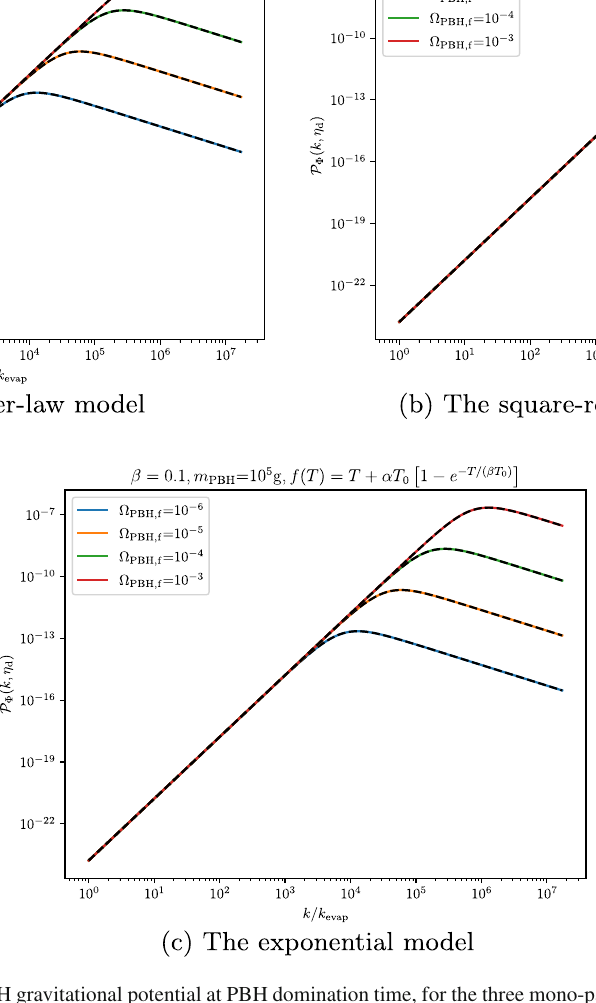
Fig. 1 The power spectrum of the PBH gravitational potential at PBH domination time, for the three mono-parametric f ( T ) models, by choosing different values of the initial PBH abundance (cid:13) PBH , f . In all graphs we have used β = 0 . 1 and m PBH , f = 10 5 g. The dashed curves correspond to the GR